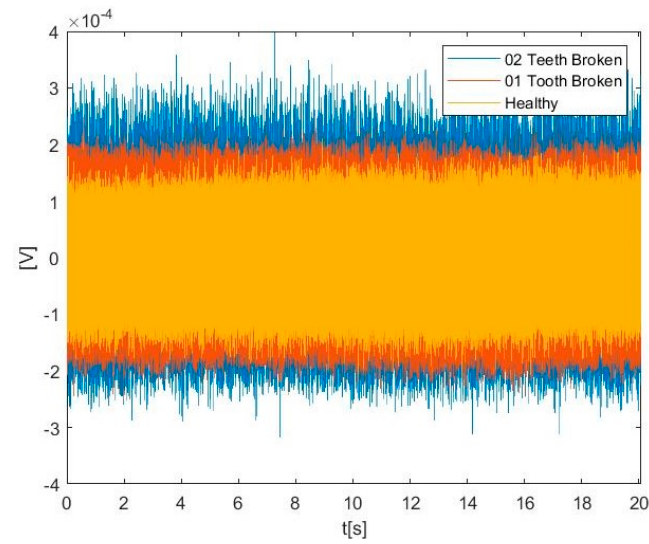
Figure 1. Vibration signals in time domain.